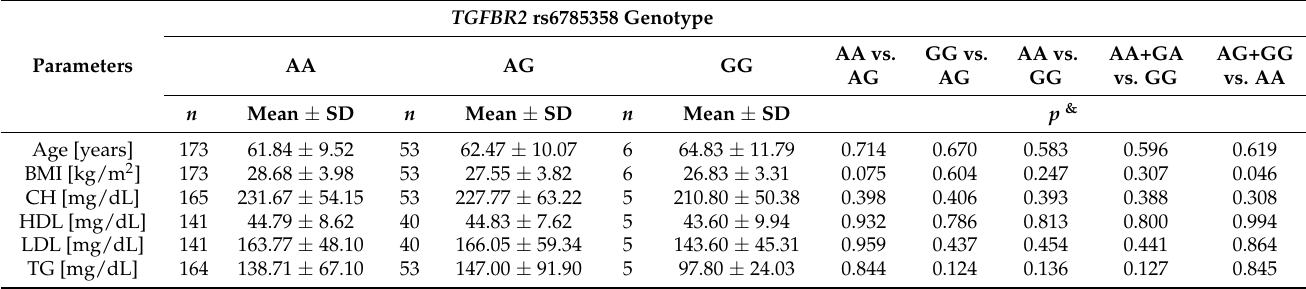
Table 7. Associations between the clinical parameters of patients with unstable angina and the TGFBR2 rs6785358 genotypes.